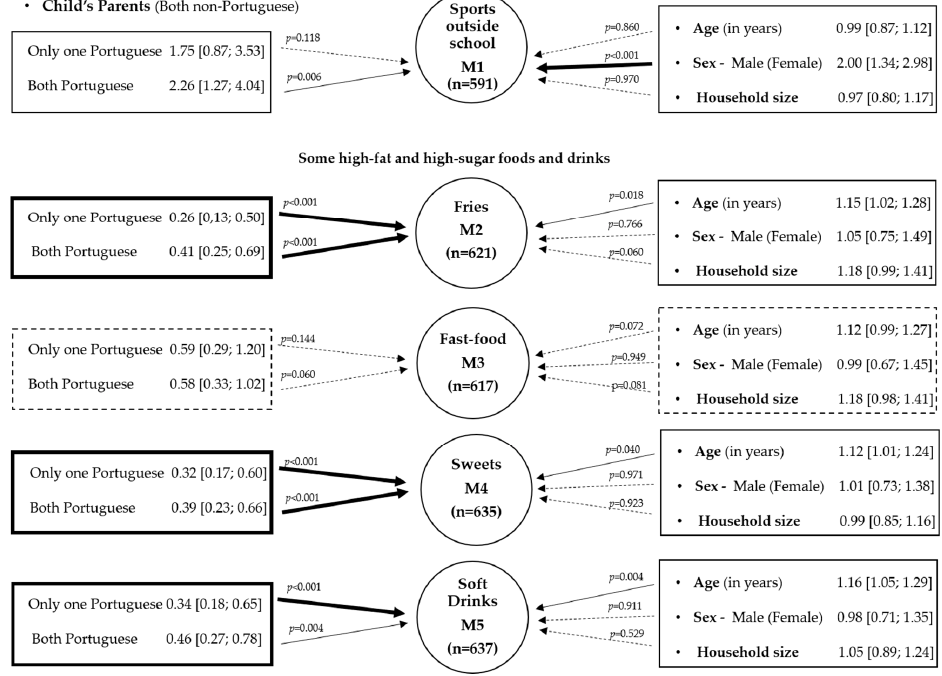
Figure 3. Results of five models (M1–M5). Each dependent variable is within circles and explanatory variables (or their categories) are within rectangles. Values correspond to adjusted odds ratio (with 95% CI). Thick line arrows indicate very significant associations ( p < 0.001), solid line arrows show significant associations (with 0.001 < p ≤ 0.05), and dashed lines denote no association ( p > 0.05). In all models, we considered “Both father and mother of the child are non-Portuguese” as the reference category. From model M1, the adjusted odds ratio indicated that children with father and mother of the Portuguese origin, compared with non-Portuguese parents, had 2.26 times more chance to practice sport outside school. On the right side, Figure 3, a significant association with sex revels that the odds of practicing sport outside school for male children is 2.0 times that of the female children. Models M2, M4, and M5 revealed a disadvantageous situation for children with non- Portuguese parents in terms of fries, sweets, and soft drinks consumptions (every day or almost every day). In addition, these models revealed associations with age. According to the fitted models, for a